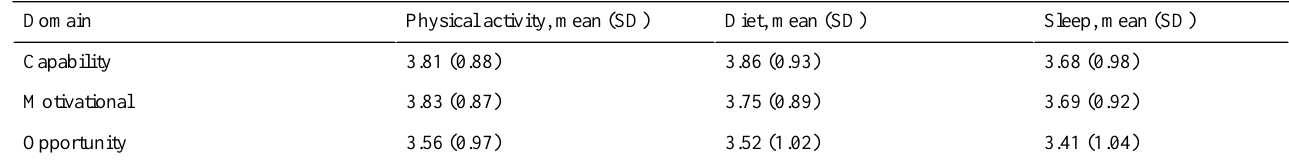
Table 3. Parents’ratings of helpfulness of overall TDF by health behavior.